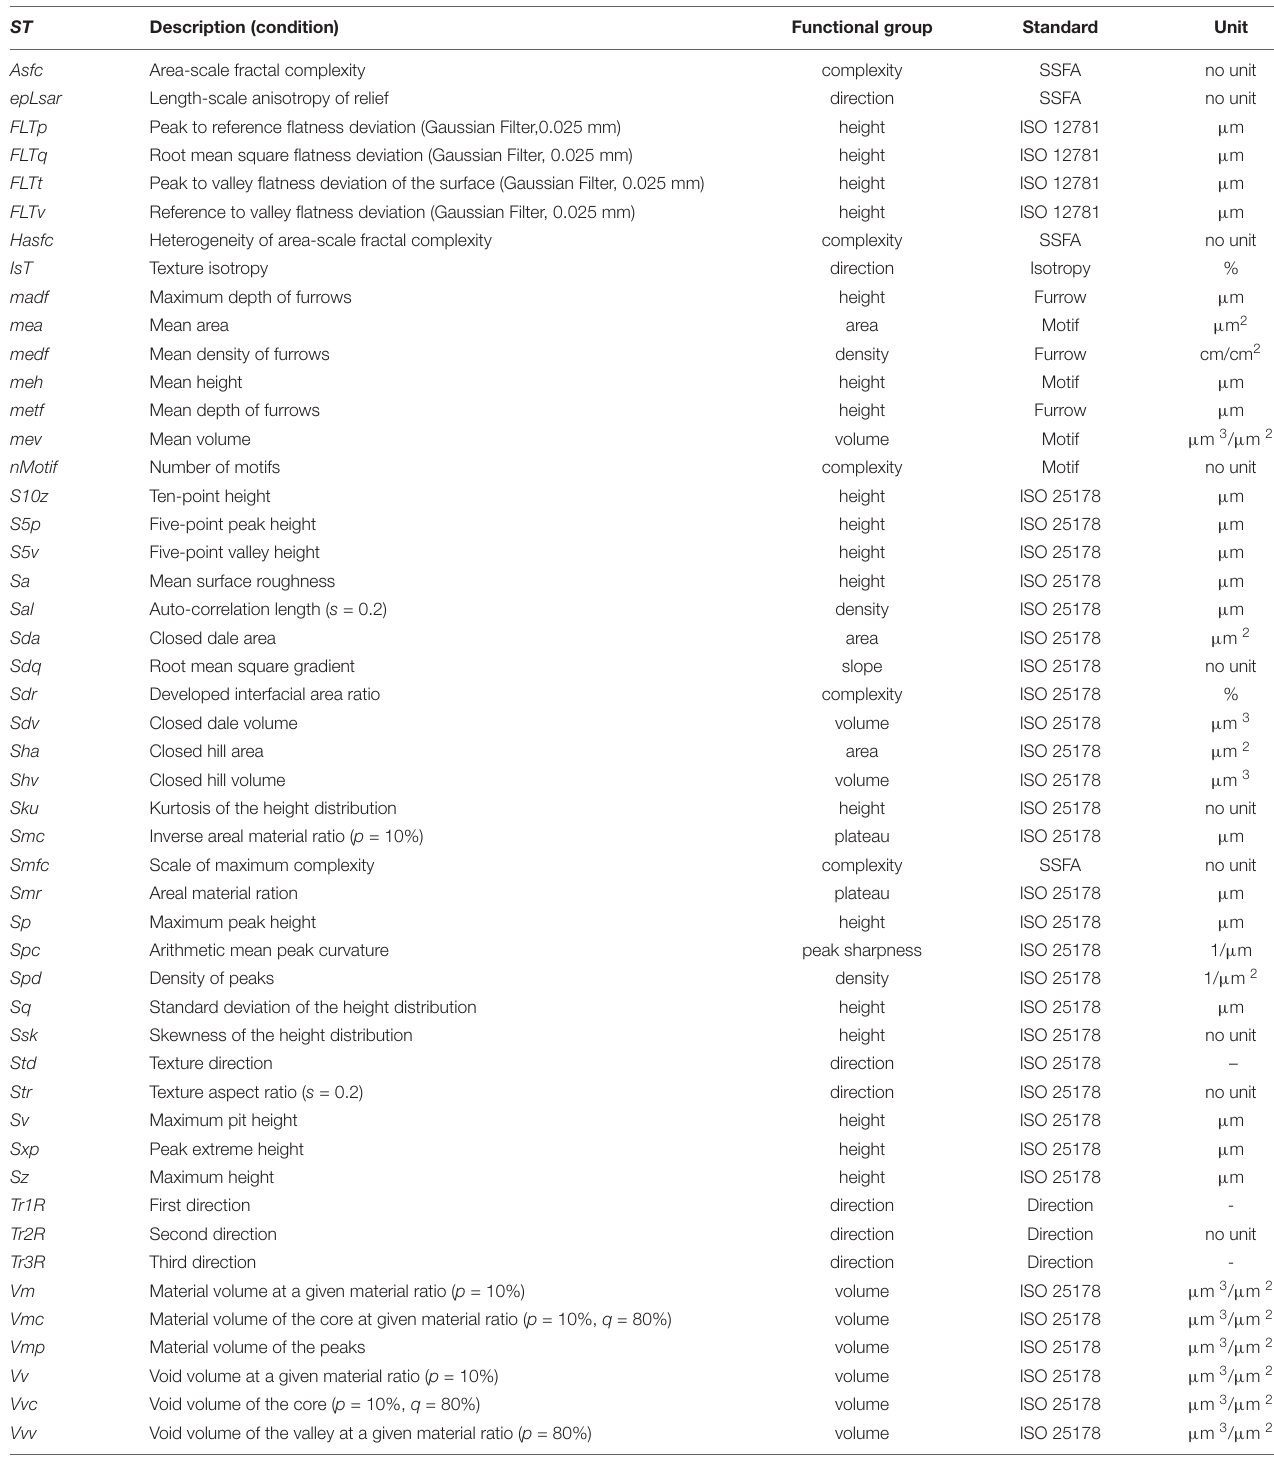
TABLE 2 | Description of applied microwear texture parameters according to ISO 25178, ISO 12781, motif, furrow, texture direction, isotropy and